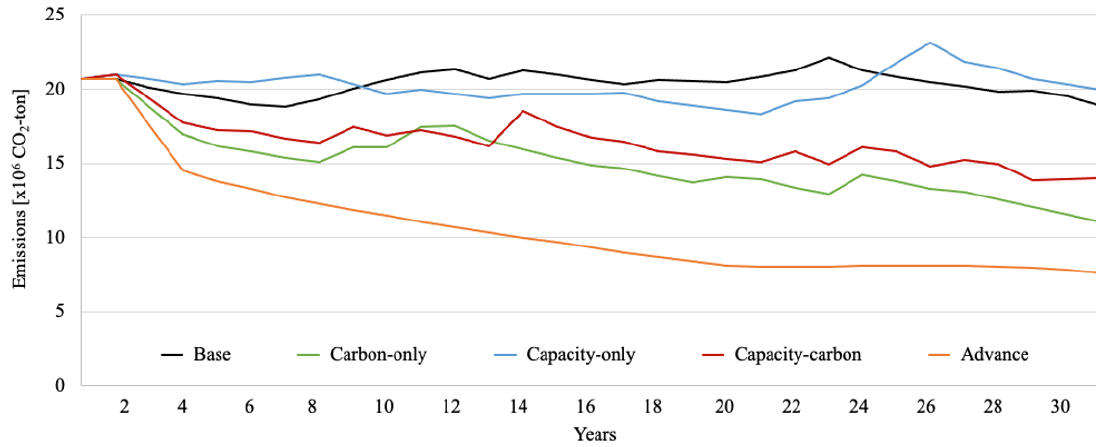
Figure 13. The trajectory of total CO 2 emission change.